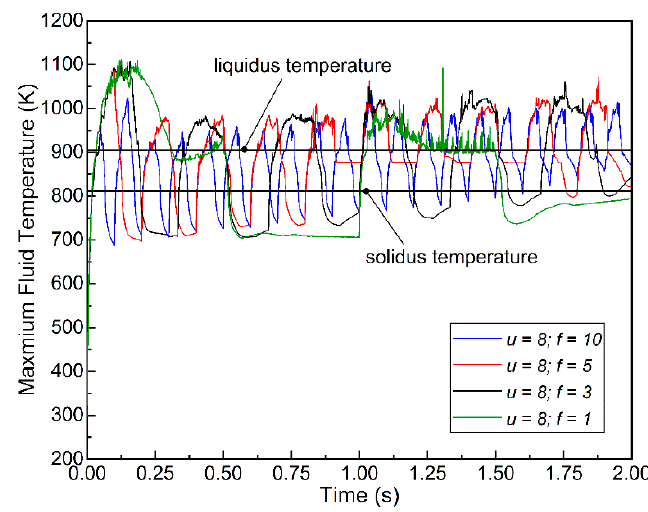
Figure 12. Variation of maximum fluid temperature with pulse frequency. Metals 2018 , 8 , x 17 of 19